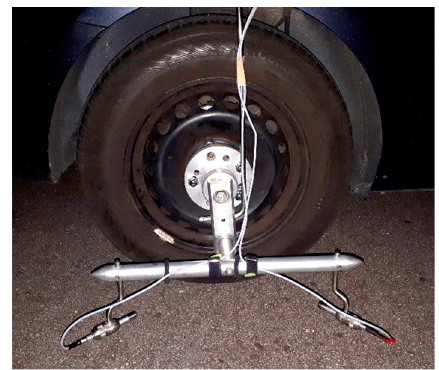
Figure 4. Set ‐ up of the microphones (B&K type 4190) assembled on a vehicle. Figure 4. Set-up of the microphones (B&K type 4190) assembled on a